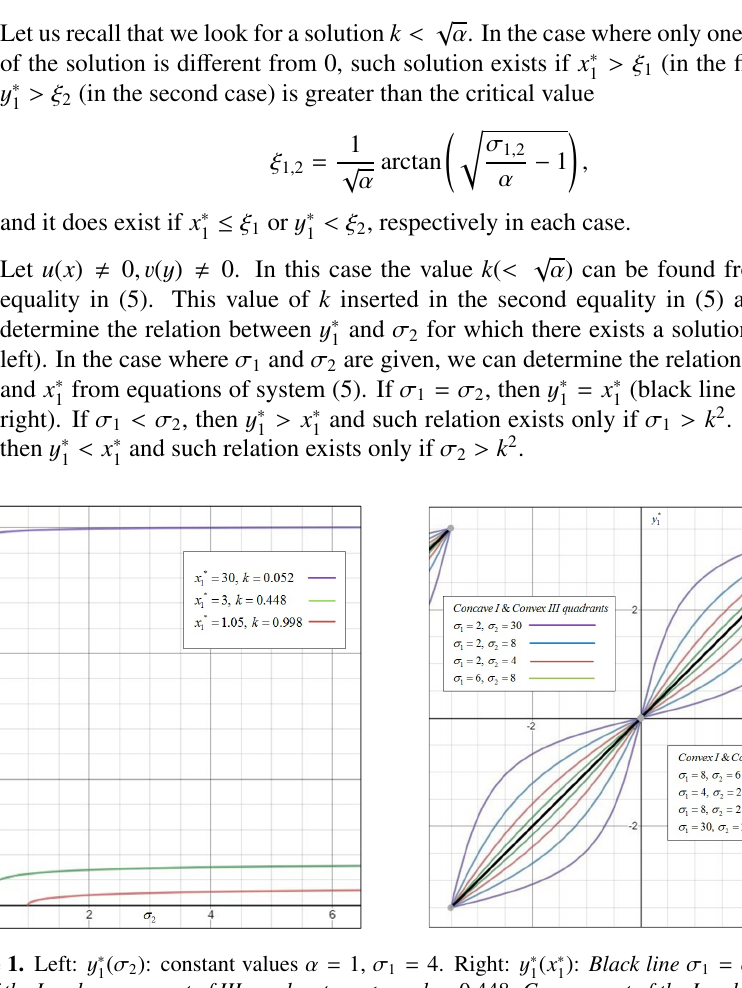
( σ 2 ): constant values α = 1, σ 1 = 4. Right: y ∗ Figure 1. Left: y ∗ 1 part of the I and convex part of III quadrant σ 1 < σ 2 : k = 0 . 448. Convex part of the I and concave part of III quadrant σ 1 > σ 2 : k = 0 .